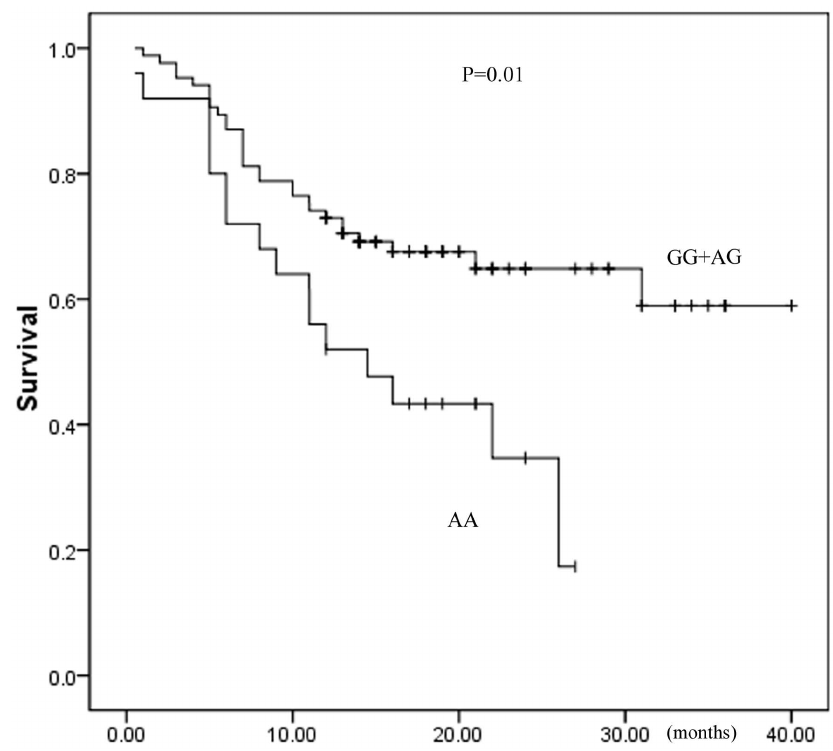
Figure 1. Association between LTA rs1800683G . A genotypes and PFS in DLBCL.